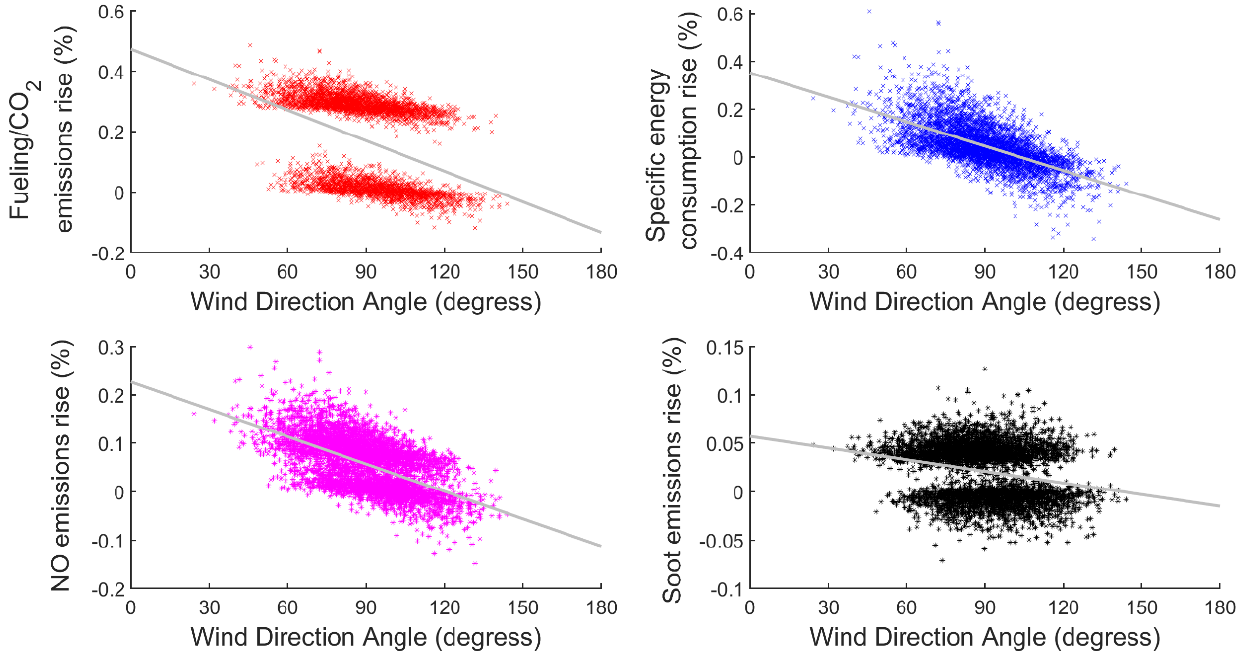
Figure 14. Percentage increase in fuel/energy consumption and emissions vs. mean wind direction for the low phase of the WLTC.